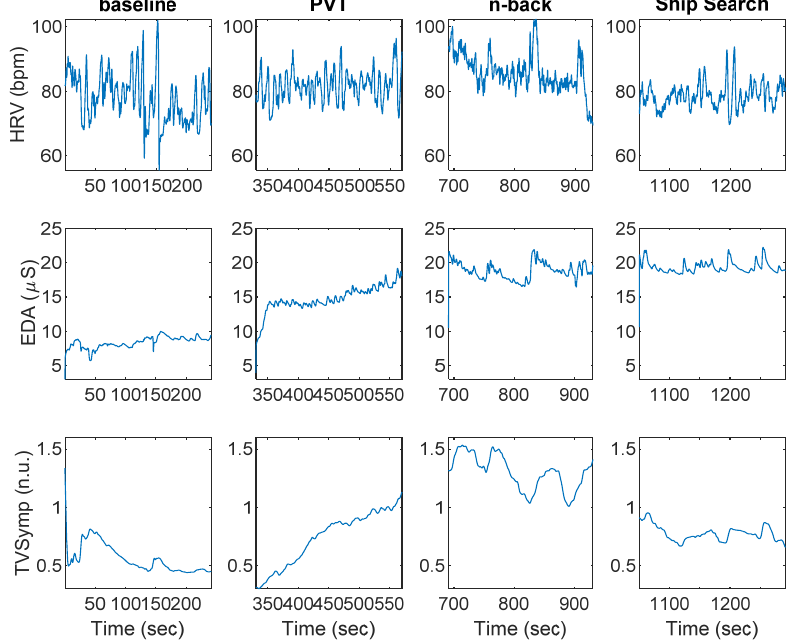
Figure 2. Heart rate variability (HRV) and electrodermal activity (EDA) data collected during baseline, the psychomotor vigilance task (PVT), n-back, and ship search for a given subject. Table 1. Indices of HRV and EDA during baseline, PVT, n-back, and ship search (SS) tasks.